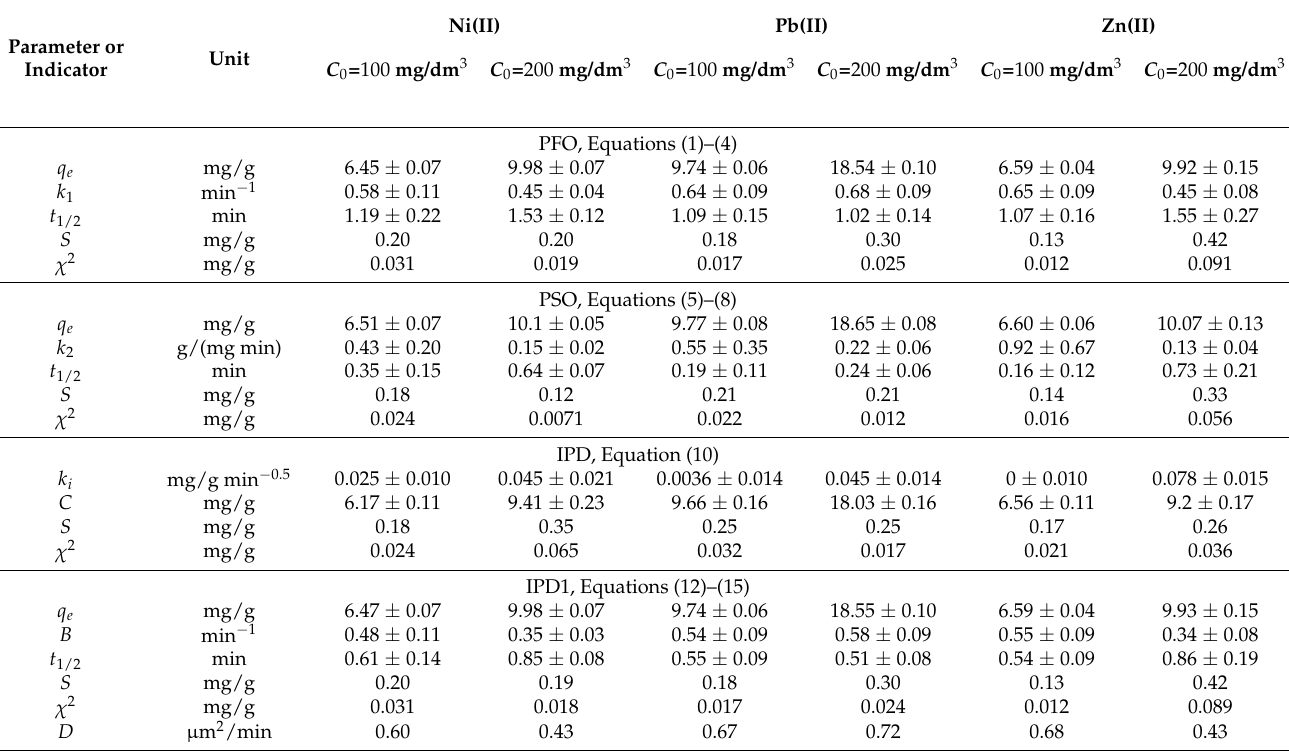
Table 7. Kinetics analysis results (bold values for S and χ 2 indicate the best